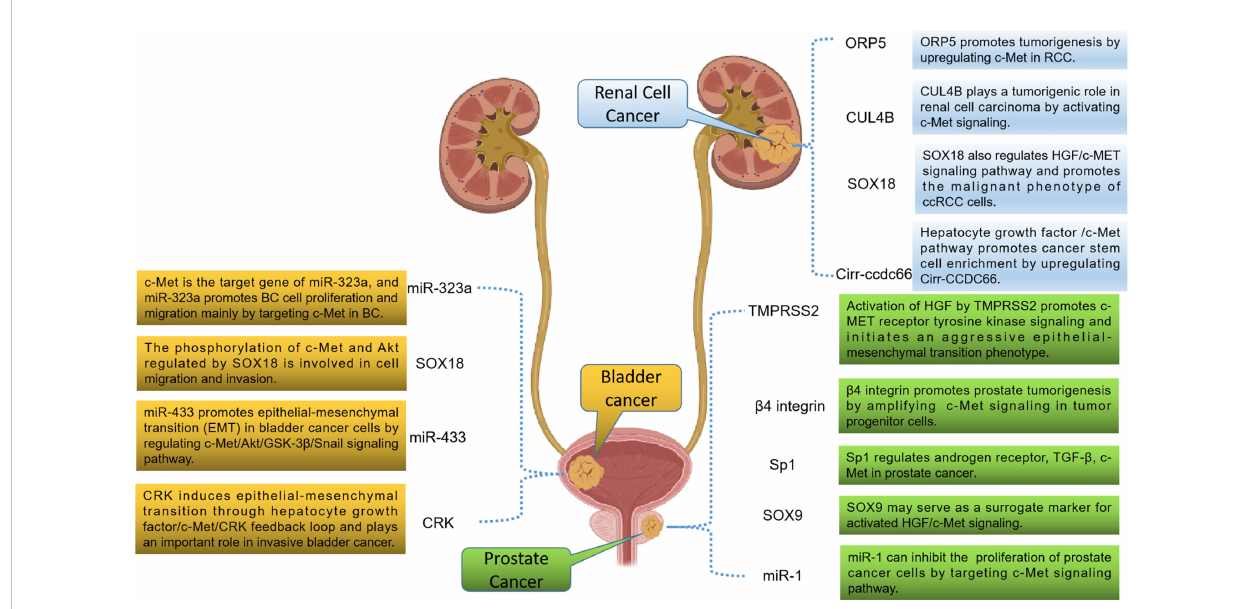
FIGURE 2 Potential therapeutic targets related to the HGF/c-Met signaling pathway in urologic